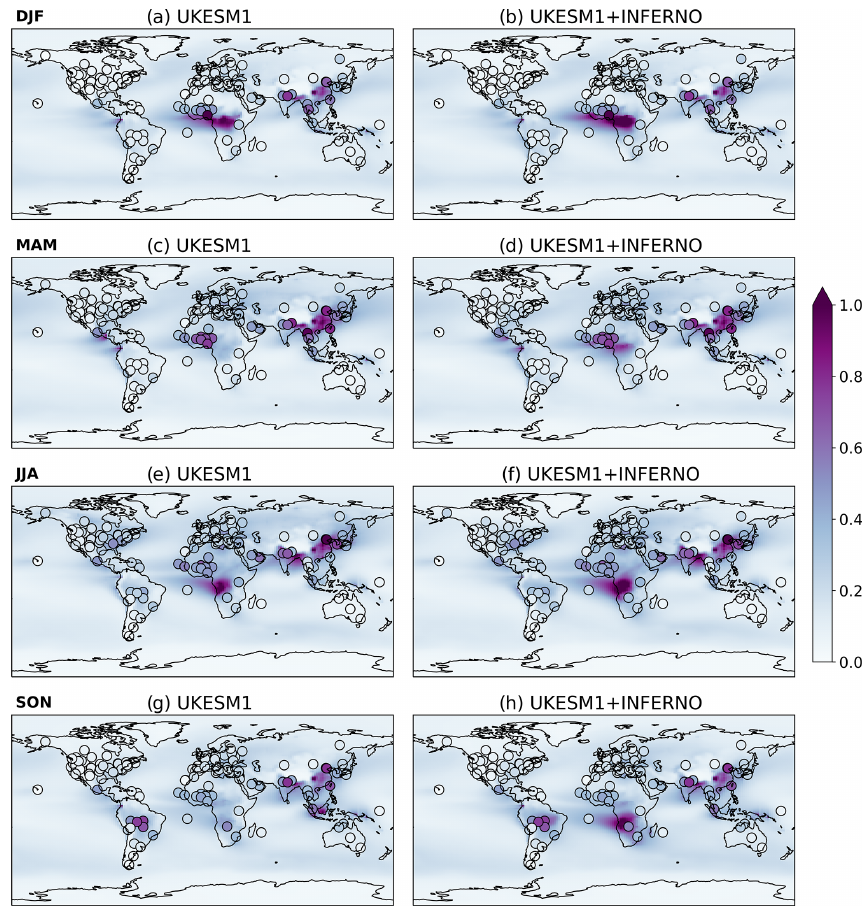
Figure 13. Aerosol optical depth mean seasonal average at 440nm (1980–2014) for the climatological seasons of DJF, MAM, JJA and SON (represented in each row) for UKESM1 (a, c, e, g) and UKESM1+INFERNO (b, d, f, h) . The ground-based aerosol optical depth retrievals at various AERONET sites that have at least a 5-year overlapping period with model data are overlaid in circles using the same colour